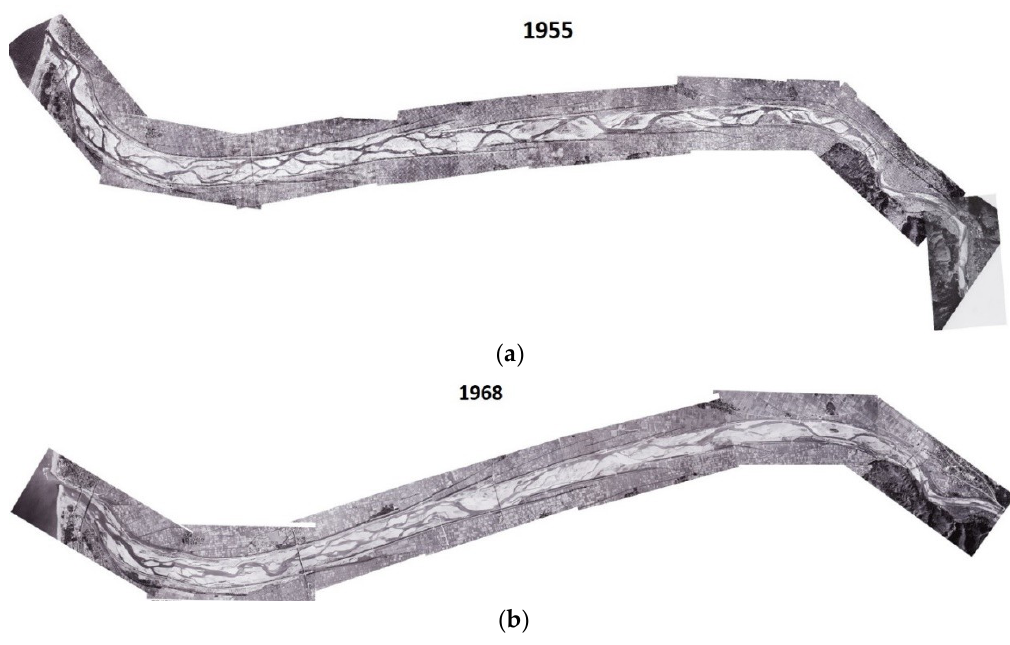
Figure 13. Temporal variation in total stream power and sediment mean diameter ( d m ) of lower Tedori River (LTR).